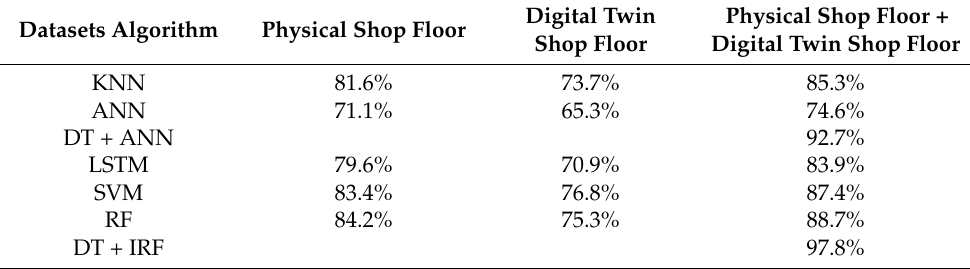
Table 3. The accuracy of each